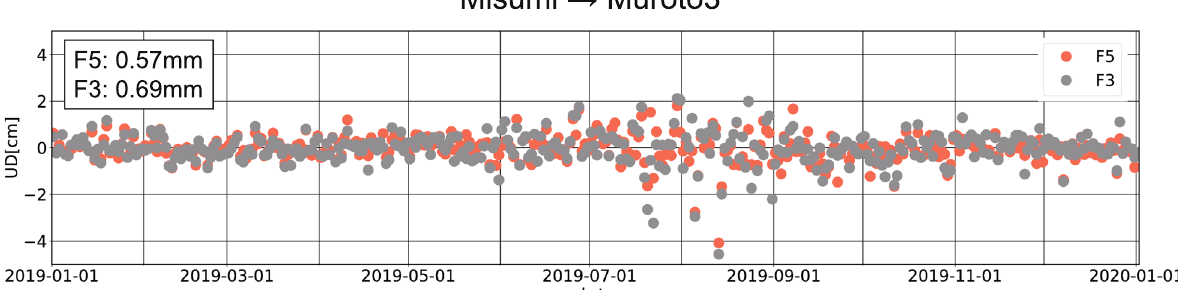
Fig. 9 Change in the UD baseline vector at Muroto-3 with respect to Misumi. The deviation from the mean component is drawn. Each RMS value with respect to the mean component is listed at the top left of the figure